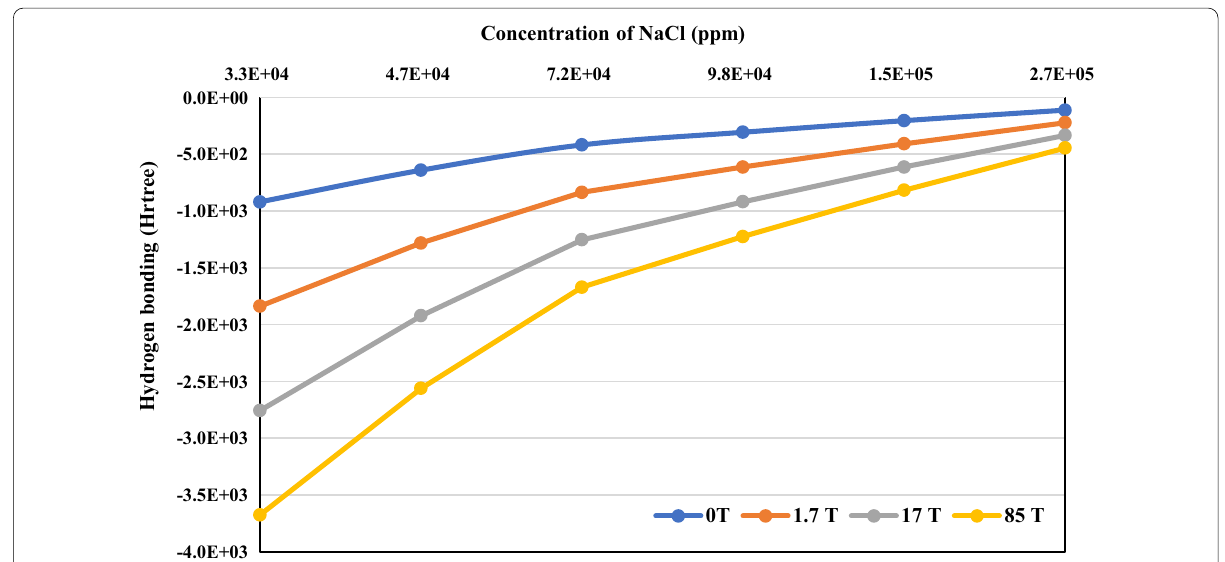
Fig. 15 Variation of hydrogen bonding versus PPM of water–NaCl system at different magnetic fields; (0–1.7–17 and 85 T